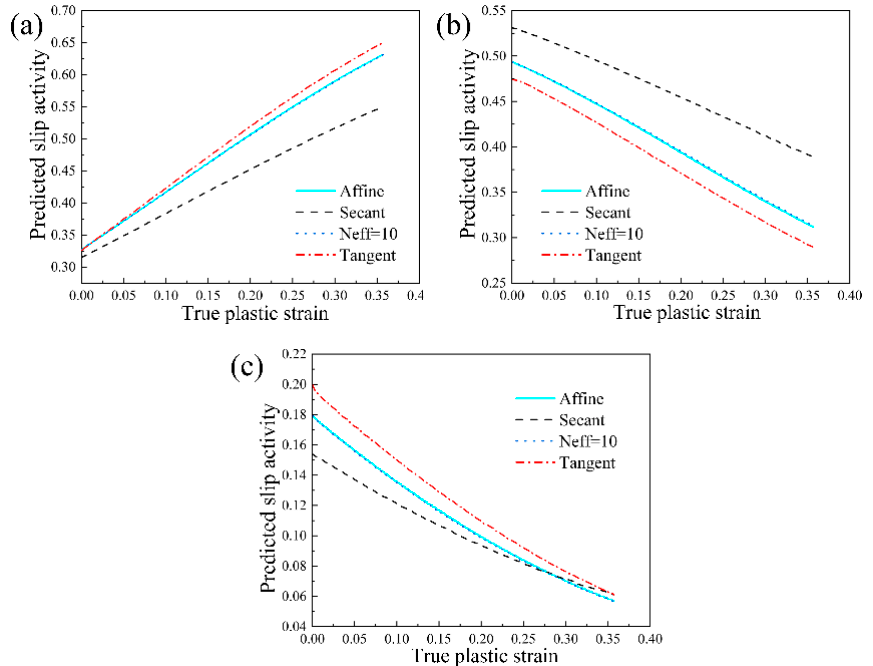
Figure 4. The simulated slip mode activities at the deformation degree of 30% in the case of various linearization schemes in the VPSC model: ( a ) {110} <100> slip mode; ( b ) {110} <111> slip mode; ( c ) {010} <100> slip mode.